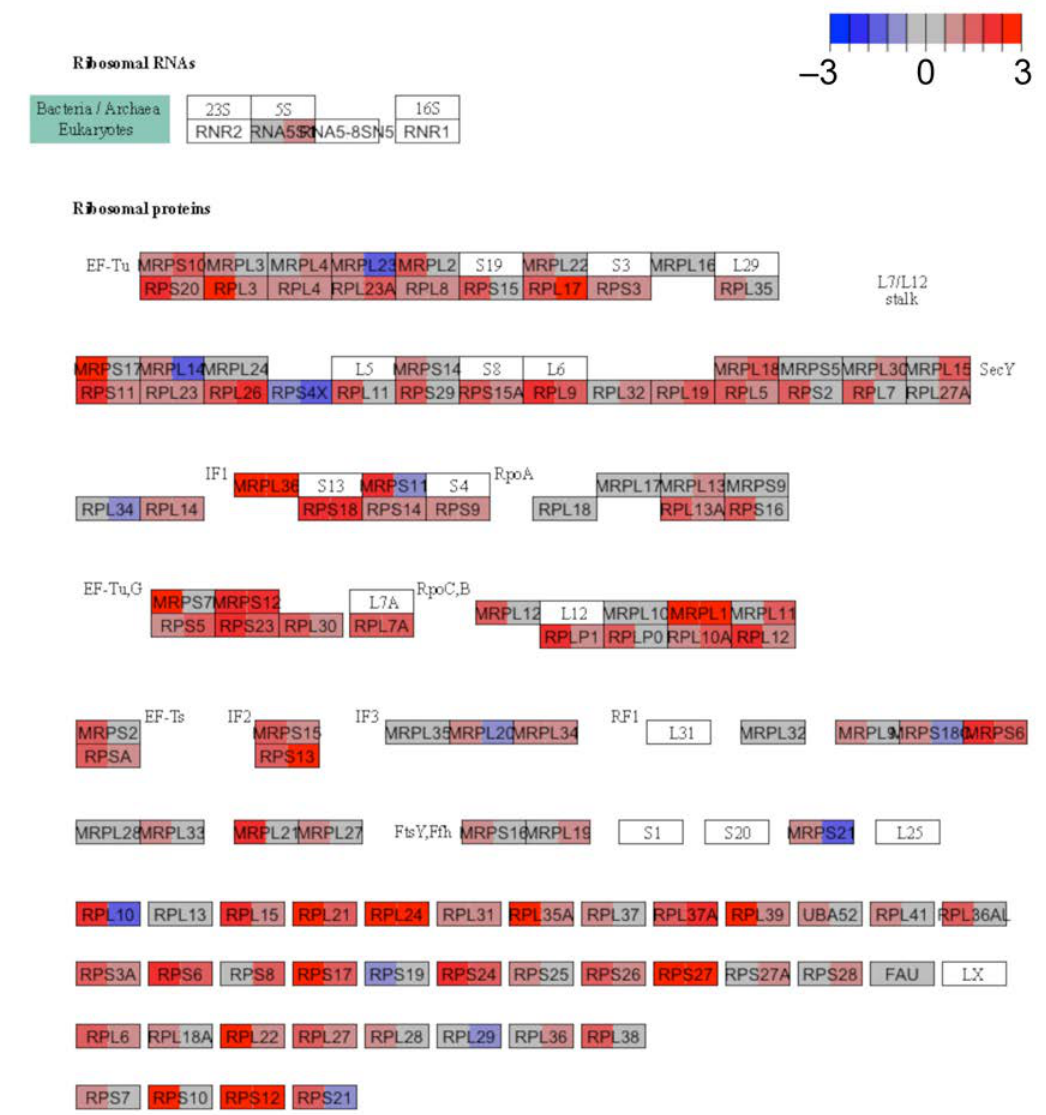
Figure 2. Ribosome pathway schematic highlighting gene expression changes in diabetic kidney disease. Gene expression changes between diabetic and reference kidneys are mapped to the KEGG ribosome pathway. Each box represents the fold change in expression between diabetic and reference in the glomerulus (left half of box) and proximal tubules (right half of box). Red indicates increased expression in diabetics. Blue indicates decreased expression in diabetics. White boxes indicate that genes involved in the subunit were not detected.